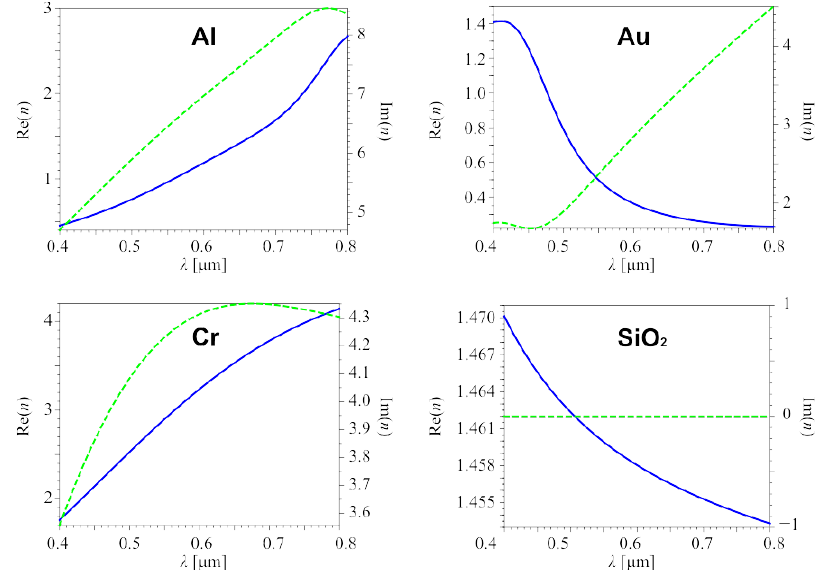
Figure 3. The refractive indices of proposed materials plotted by using models (2)–(3) and parameters from Tables 2–5. Real part is presented by blue solid line, image part is presented by green dashed line.